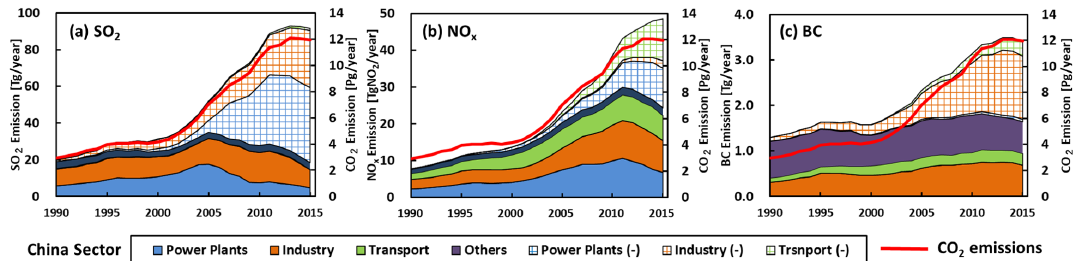
Figure 3. Emissions of (a) SO 2 , (b) NO x , and (c) BC from each major sector in China during 1990–2015. Solid colored areas are actual emissions, and hatched ones (–) are reduced emissions due to control measures. Red lines in the panels are total CO 2